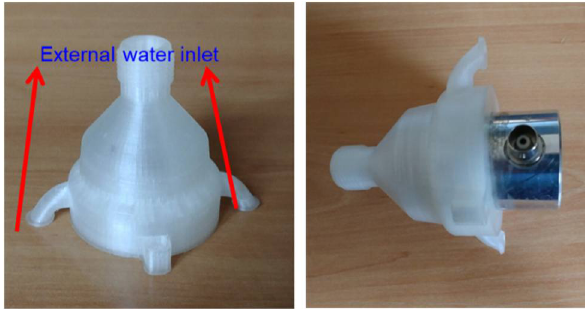
Figure 7. Nozzle used for the